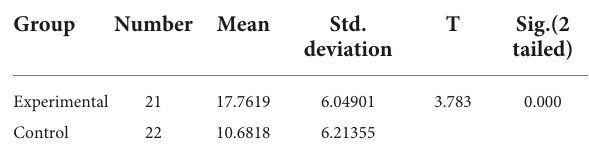
TABLE 4 Independent samples t -test for the difference in the mean scores of (WDT) post-test for the experimental group and the control group.